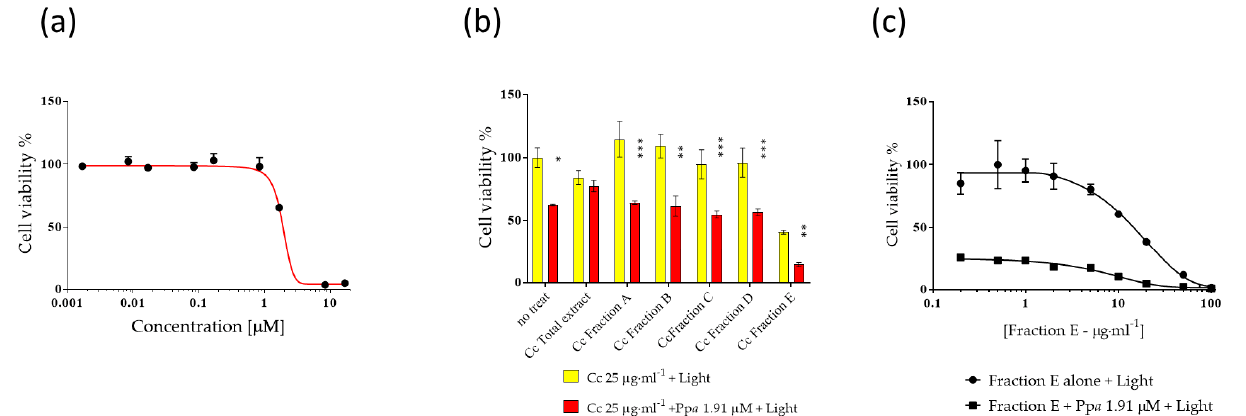
Figure 1. Activity of Pheophorbide a (Pp a ) and Cylindrotheca closterium (Cc) against melanoma cells (A2058). The figure shows ( a ) the dose-dependent activity of Pp a , ( b ) Cc fractions (from A to E) activity alone or in the presence of 1.91 µ M of Pp a (IC 50 ) plus light, ( c ) the dose-dependent activity of Fraction E from Cc alone or with 1.91 µ M Pp a (IC 50 value) plus light. No treat means without Cc. Control cells were incubated with complete cell medium and DMSO. Results are expressed as percent survival after 24 h exposure followed by 1 h photo-activation (* p < 0.05; ** p < 0.01; *** p < 0.001).